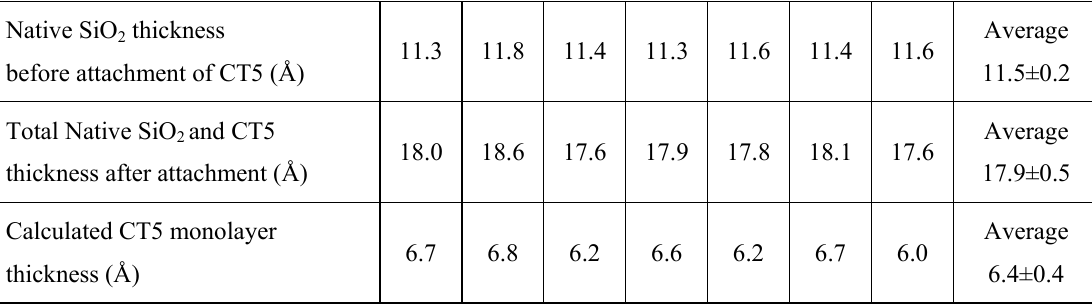
substrate. Shown in (A), (B), 2